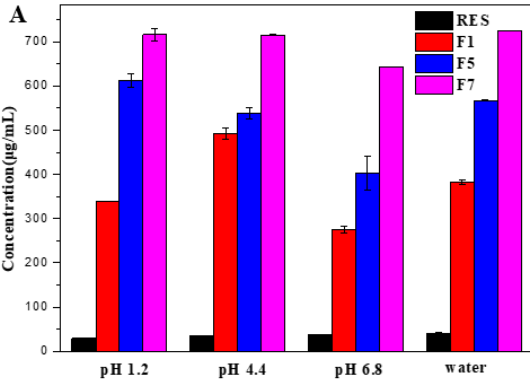
Figure 7. Equilibrium concentrations of RES ( A ), PIP ( B ), and the representative spray-dried micro-